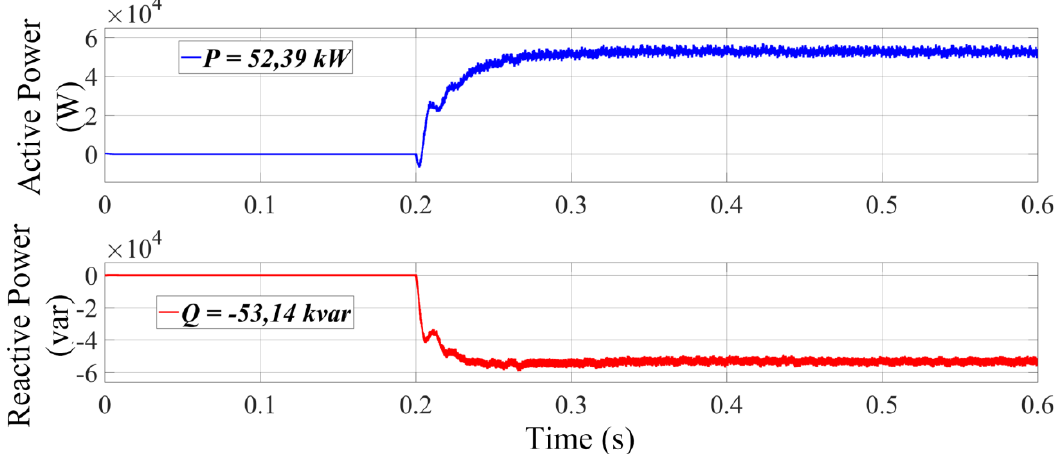
Figure 16. Active power (upper, 20 kW/div) and reactive power (lower, 20 kvar/div) that circulates at transformer with F p = 0.7. Horizontal axis: 100 ms/div.